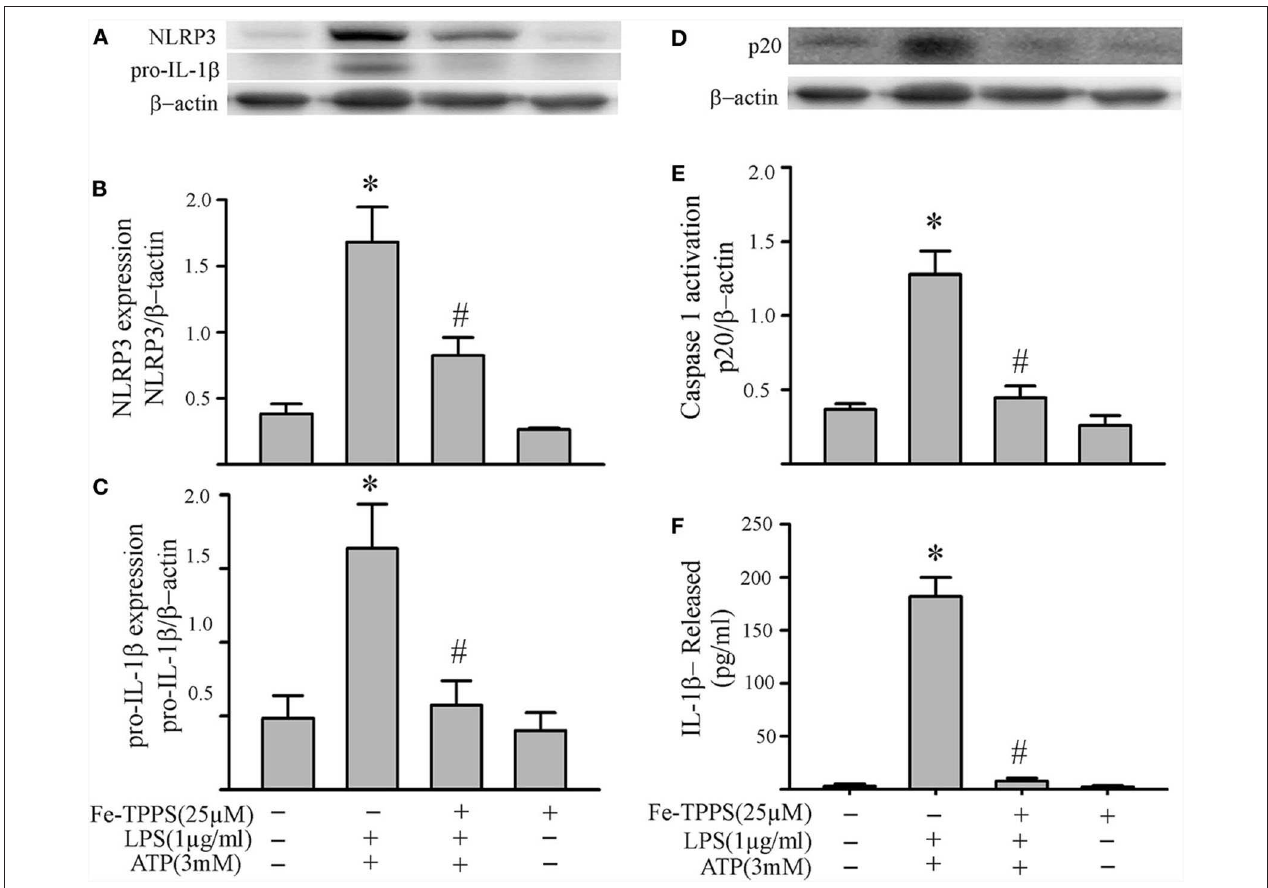
FIGURE 7 | A peroxynitrite decomposition catalyst (Fe-TPPS) decreases NLRP3 inflammasome priming/activation in LPS/ATP challenged fibroblasts. Fibroblasts were pretreated with Fe-TPPS (25 µ M) or vehicle for 30min. Subsequently, they were challenged with LPS (1 µ g/mL) for 6h followed by ATP (3mM) for 30min. (A–C) NLRP3 and pro-IL-1 β protein levels were indices of inflammasome priming. Representative Western blots are shown in (A) and densitometric analyses in (B,C) . (D–F) Caspase1 activation (p20) and release of mature IL-1 β were indices of inflammasome activation. Representative Western blot for caspase1 p20 is shown in (D)